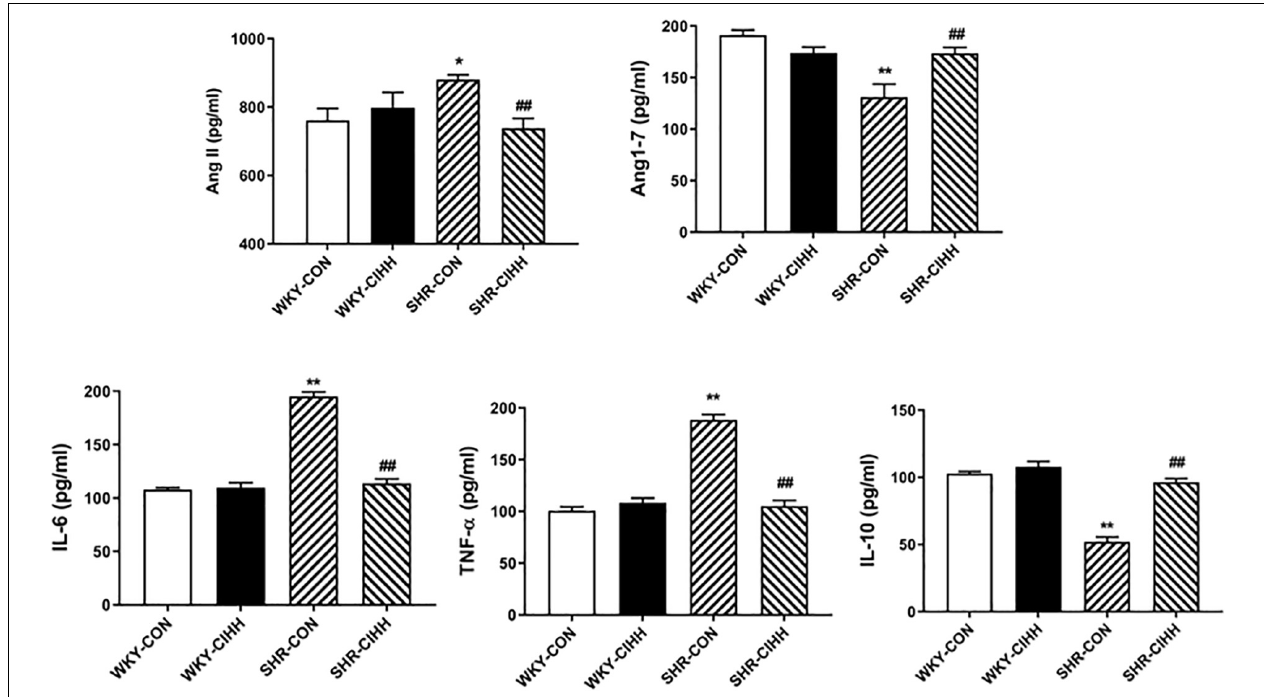
FIGURE 3 | Effect of chronic intermittent hypobaric hypoxia (CIHH) on serum angiotensin II (Ang II), angiotensin 1–7 (Ang1–7), IL-6, TNF α , and IL-10 in spontaneously hypertensive rats (SHRs). Data are expressed as mean ± SEM; SHR-CON: control SHR ( n = 14); SHR-CIHH: SHR with CIHH ( n = 14); WKY-CON: control WKY rat ( n = 6); WKY-CIHH: WKY rat with CIHH ( n = 6); * P < 0.05, ** P < 0.01 vs. WKY-CON ## P < 0.01 vs. SHR-CON (one-way ANOVA).